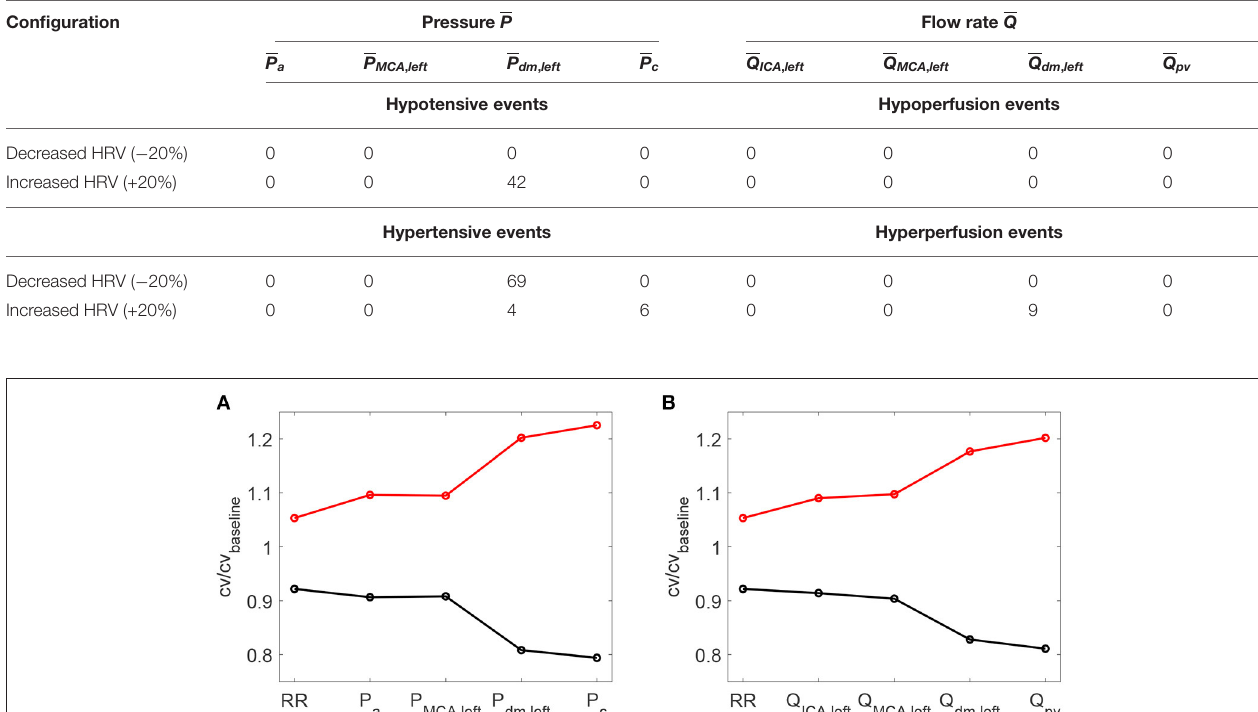
TABLE 3 | Total number of one-beat extreme events (out of 5,000 RR beats) along the ICA-MCA pathway for the two decreased and increased HRV configurations. Configuration